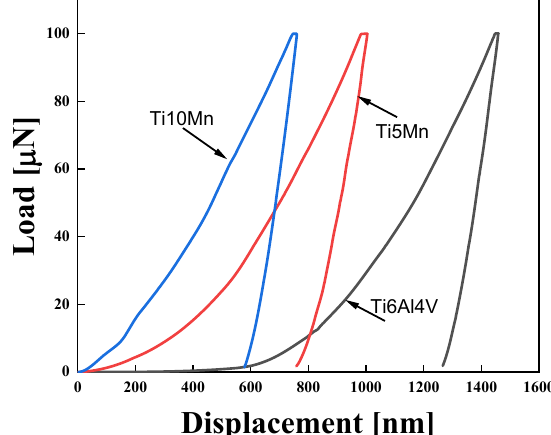
Figure 4. The different stages of the load-displacement curve of Ti-5Mn, Ti10Mn, and Ti6Al4V. The blue line represents Ti10Mn, the red line represents Ti5Mn, and the black line represents Ti6Al4V.